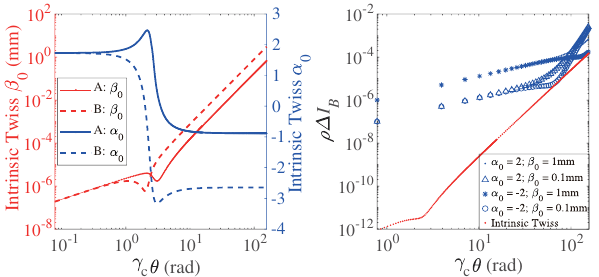
FIG. 2. To minimize the longitudinal emittance contribution of the first two kinds of dipoles (A and B), entrances β 0 and α 0 need to be matched with the IT (left). Both A and B have a same limit of Δ I B which is shown by the red dotted line in the right figure. Compared with other four cases, in the IT-matched case, Δ I B can be orders of magnitude smaller. Here, the electron energy is set to be 400 MeV, and the bending radius equals 1